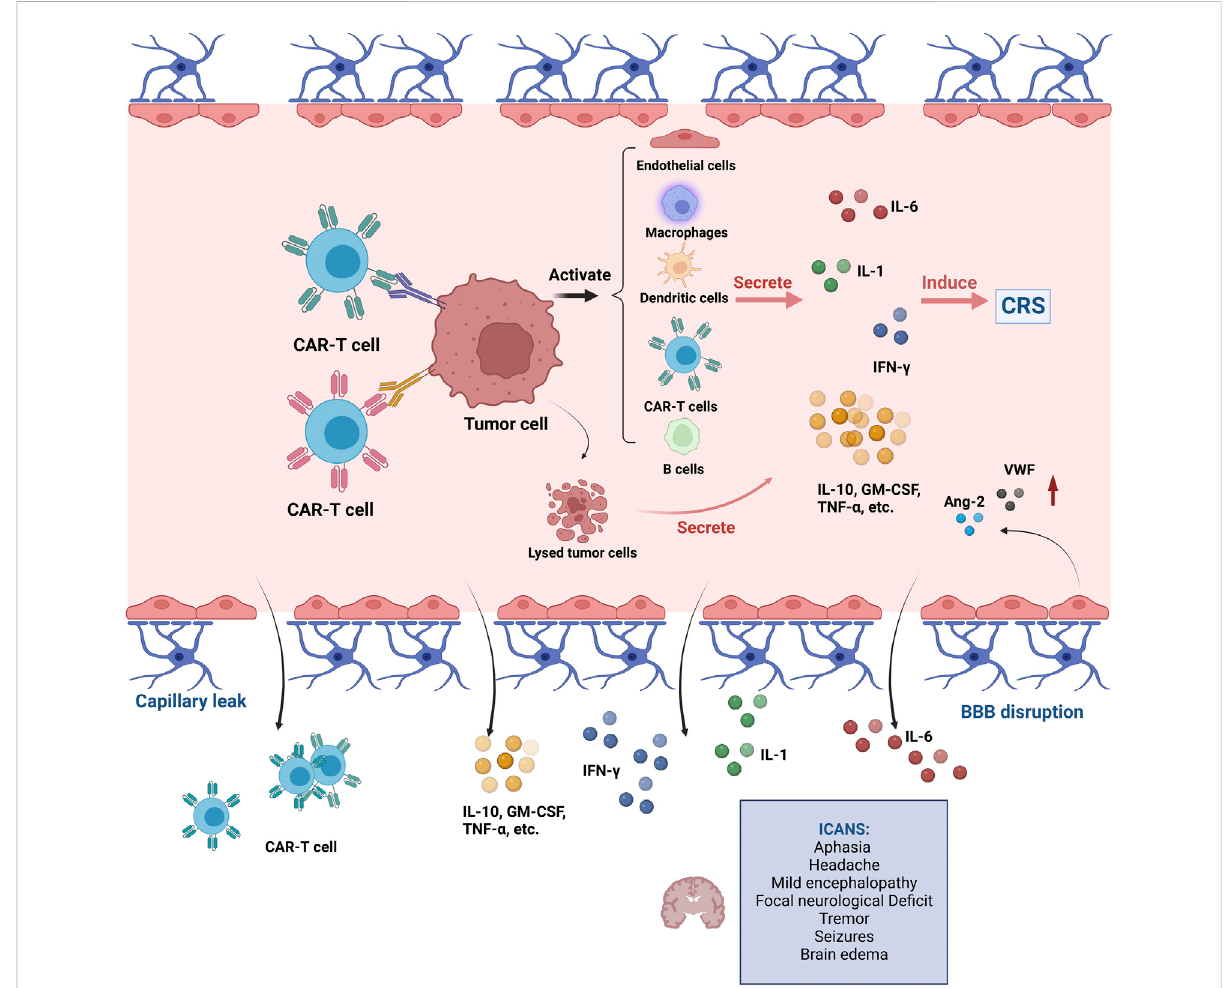
FIGURE 2 PathogenesisofICANSduringCAR-Ttherapy.Abbreviations:CAR,chimericantigenreceptor;CRS,cytokinereleasesyndrome;ICANS,immune effector cell-associated neurotoxicity syndrome; IL, interleukin; IFN- γ , interferon gamma; GM-CSF, granulocyte macrophage colony-stimulating factor; TNF- α , tumor necrosis factor alpha; BBB, blood brain barrier. This fi gure created with